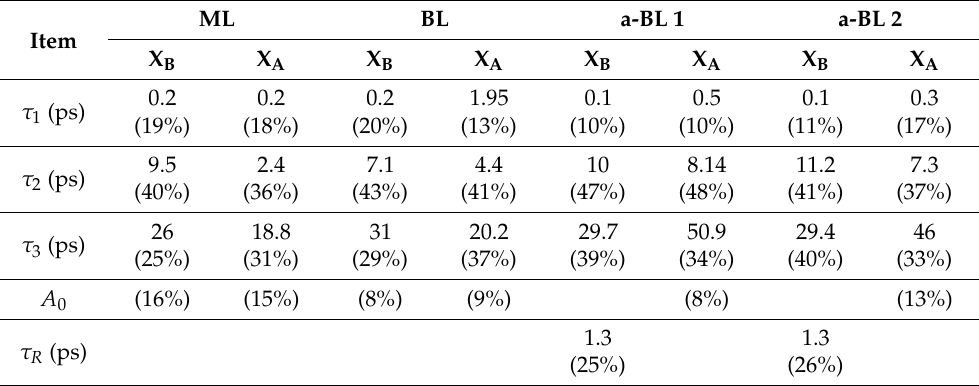
Figure 10. Pump-probe dynamics with off-resonant 2.2 eV excitation. ( a ) ML, monolayer MoS 2 . ( b ) BL, normal bilayer. ( c ) a-BL 1, anomalous bilayer 1. ( d ) a-BL 2, anomalous bilayer 2. Samples from ( a ) to ( d ) are in accordance with region 3, region 4, region 1, and region 2 in Figure 7. X B , B-exciton resonance; X A , A-exciton resonance. Table 1. Fitted decay parameters for off-resonant 2.2 eV excitation. Table 1. Fitted decay parameters for off-resonant 2.2 eV excitation.